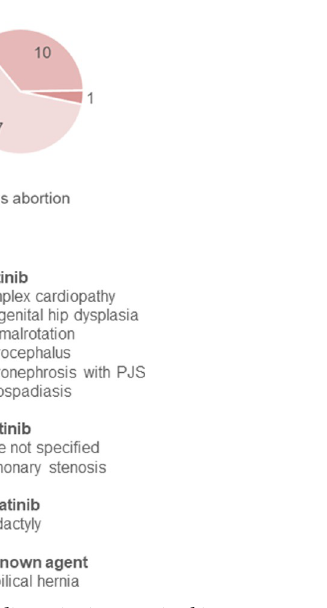
Fig 2. Characteristics of male patients not discontinuing tyrosine kinase treatment before conception. A: Distribution of pregnancy outcomes among all pregnancies (n = 428). B: Malformations among live births (n = 400). PJS: pyeloureteral junction